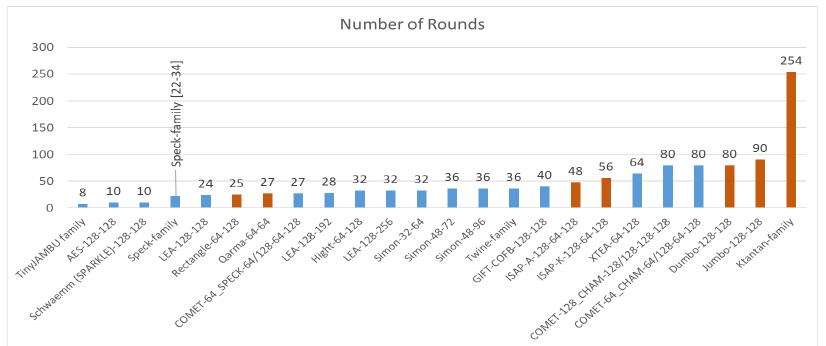
Figure 31. The best algorithms and worst throughout with their corresponding number of rounds. Brown color indicates the worst algorithms in previous measures.